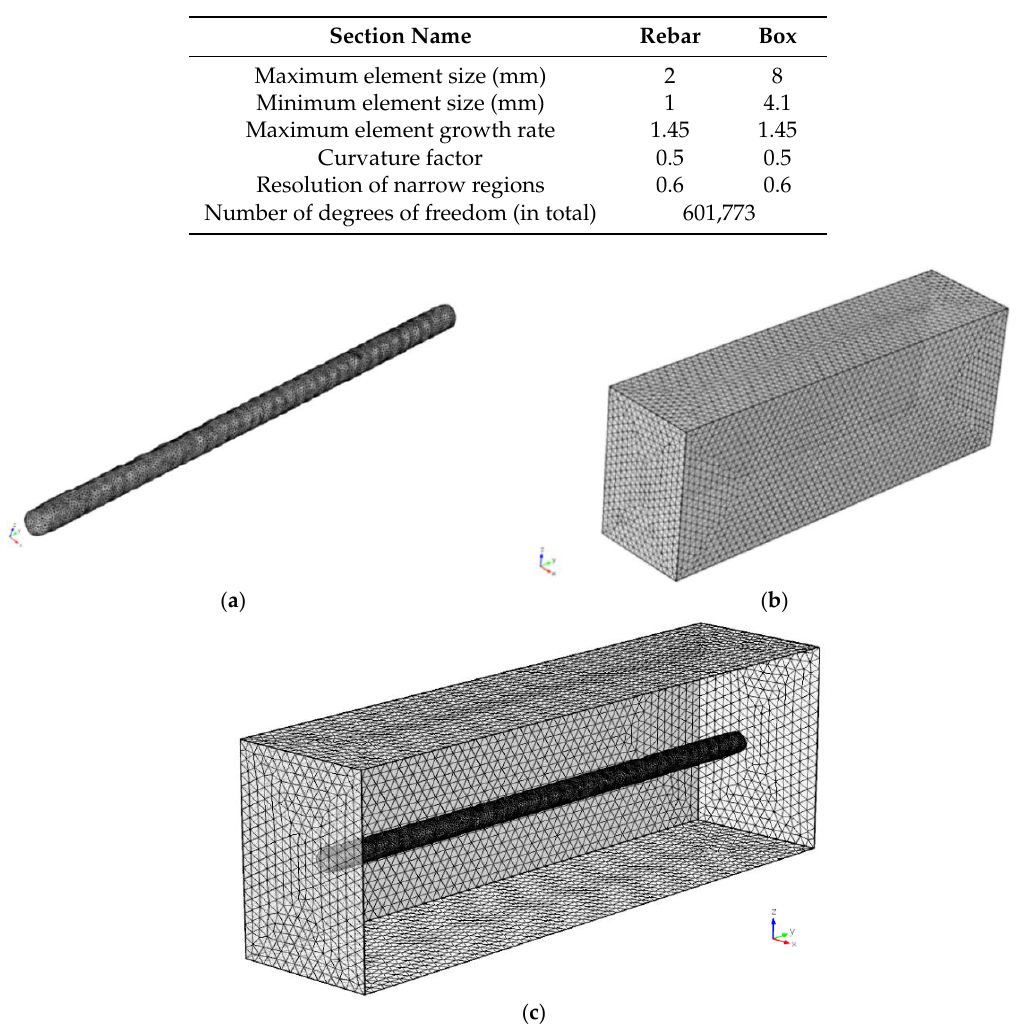
Figure 4. Initial meshes of the system: ( a ) rebar mesh with its initial sizes; ( b ) box mesh with its initial sizes; ( c ) rebar and box meshes as a single system (front face of the box is removed for better visualization).